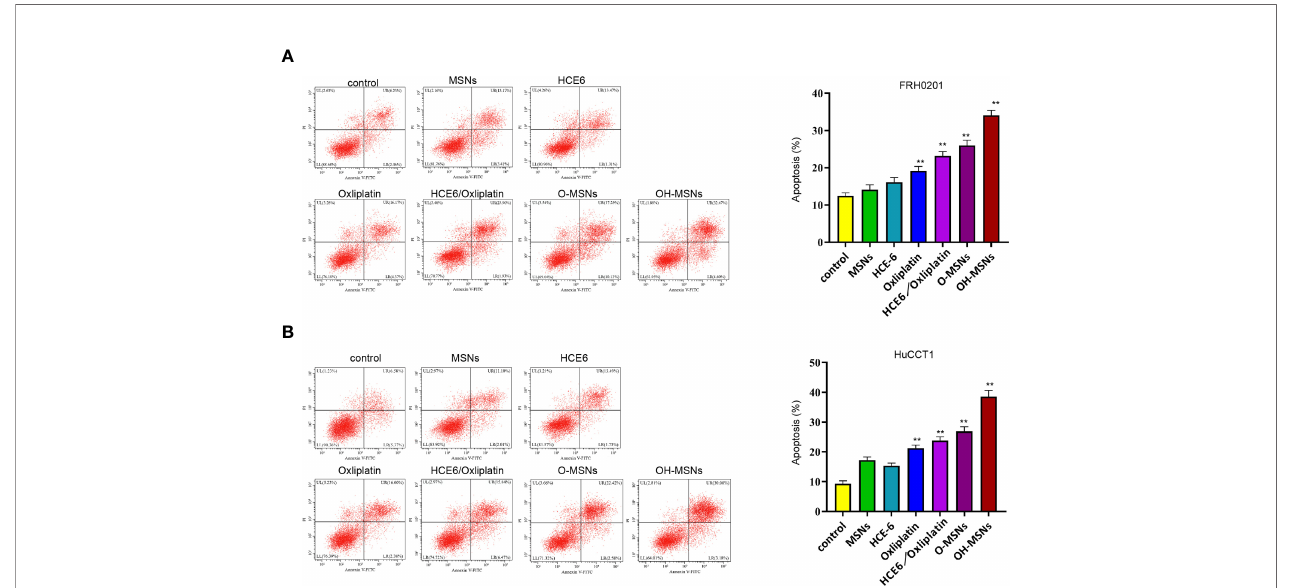
FIGURE 5 | Apoptosis level of cholangiocarcinoma cells. (A, B) The FRH0201 and HuCCT1 cells were treated as the indicated labeling. The apoptosis was analyzed by fl ow cytometry. Data are presented as mean ± SD. Statistic signi fi cant differences were indicated: **P <